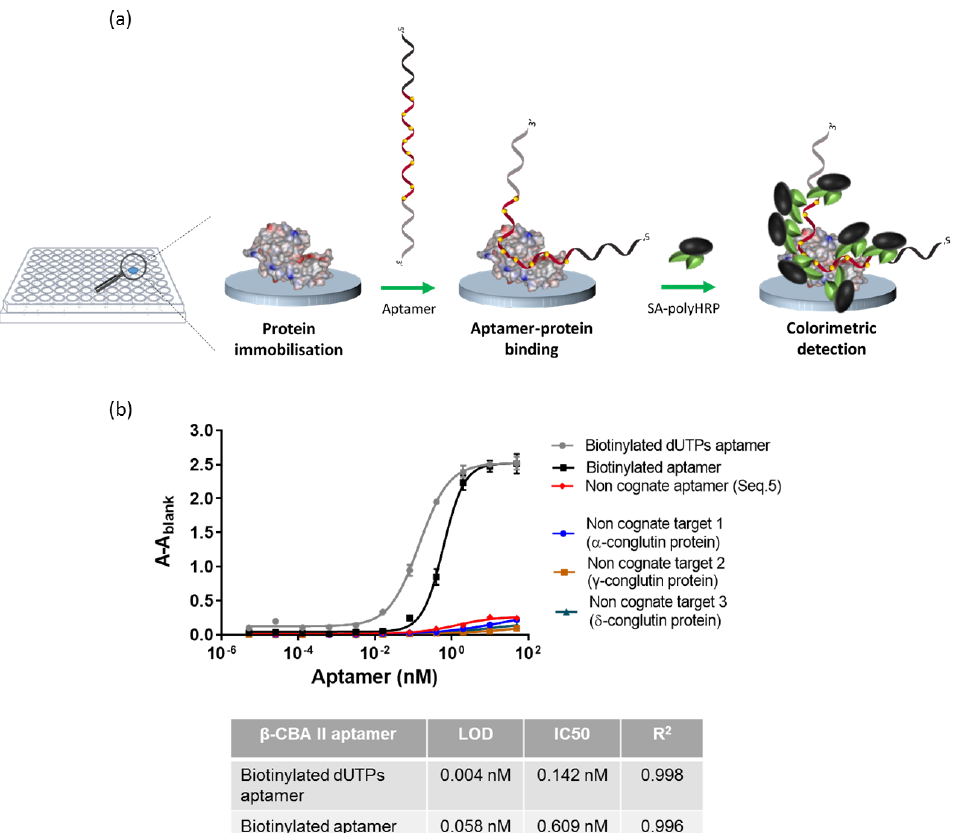
Figure 2. Evaluation of biotinylated aptamer, using an Enzyme-Linked Aptamer Assay (ELAA): ( a ) schematic representation of the assay; ( b ) binding curves comparing modified aptamer with biotinylated dUTPs and modified biotinylated aptamer (with a single biotin label) and control assays, using a non-cognate aptamer with biotinylated dNTPs, and the specific aptamer against three non- cognate targets.